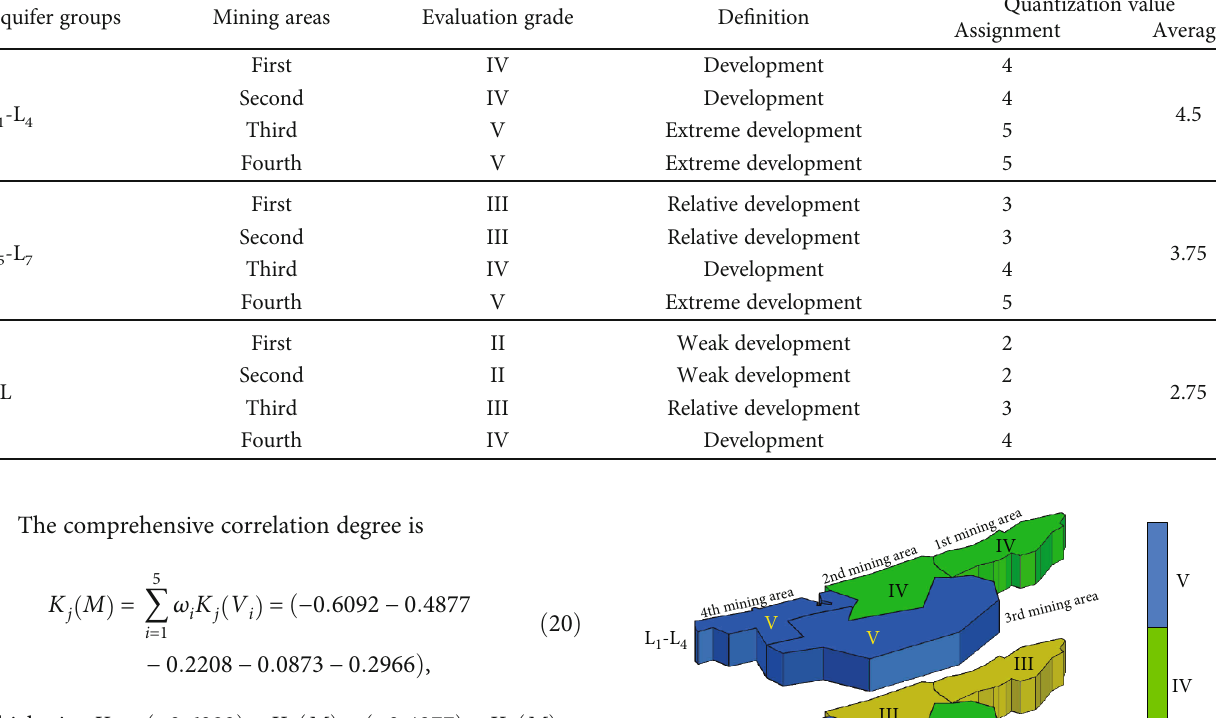
Table 6: Degree of karst development of di ff erent aquifer groups in mine No. 13. Aquifer groups